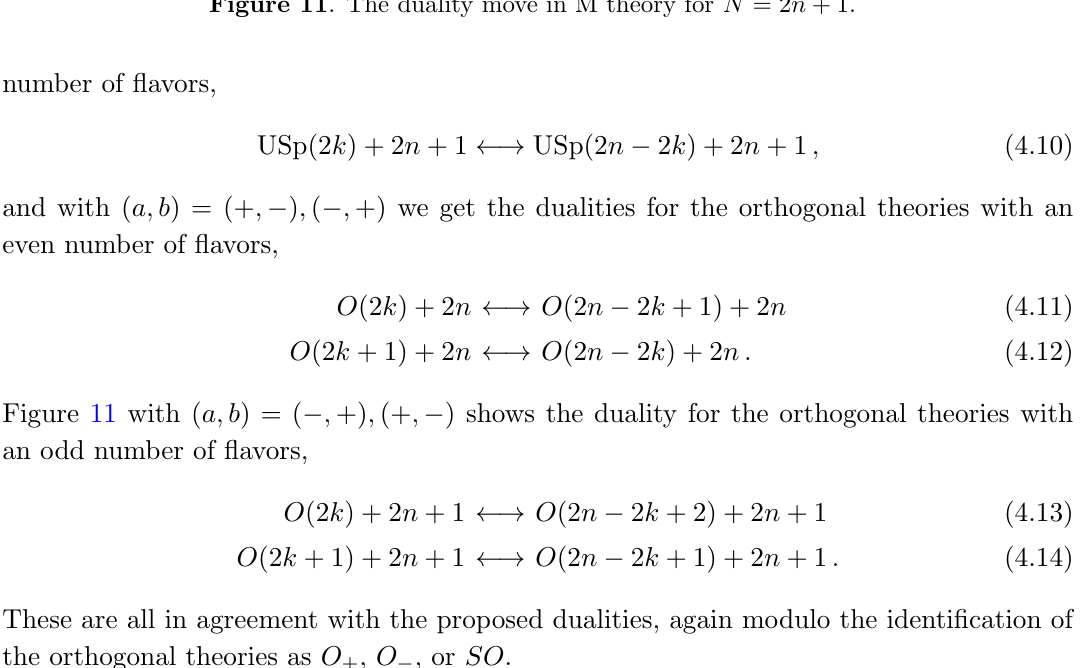
Figure 11 . The duality move in M theory for N = 2 n +